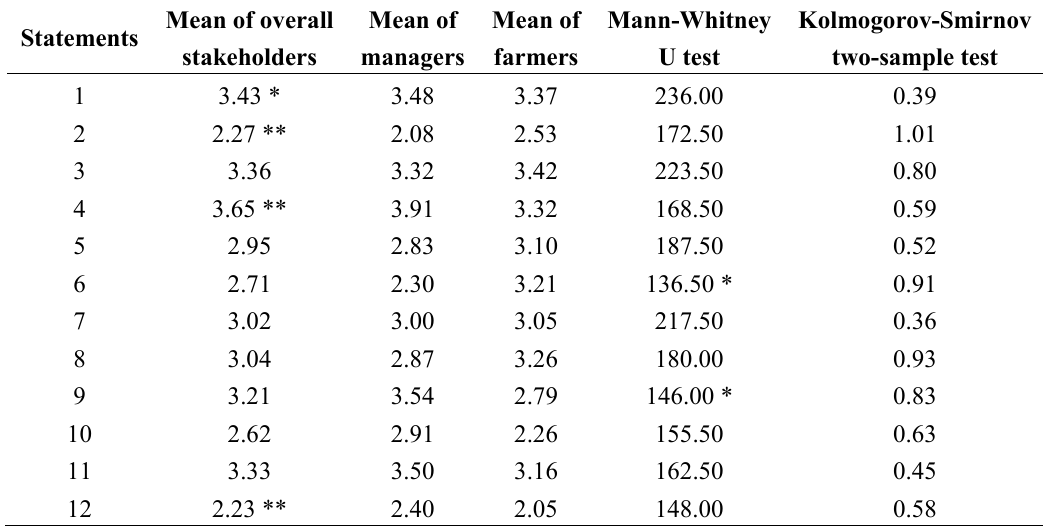
Table 4. Statistical analysis of stakeholder responses, comparing managers and farmers. Statements